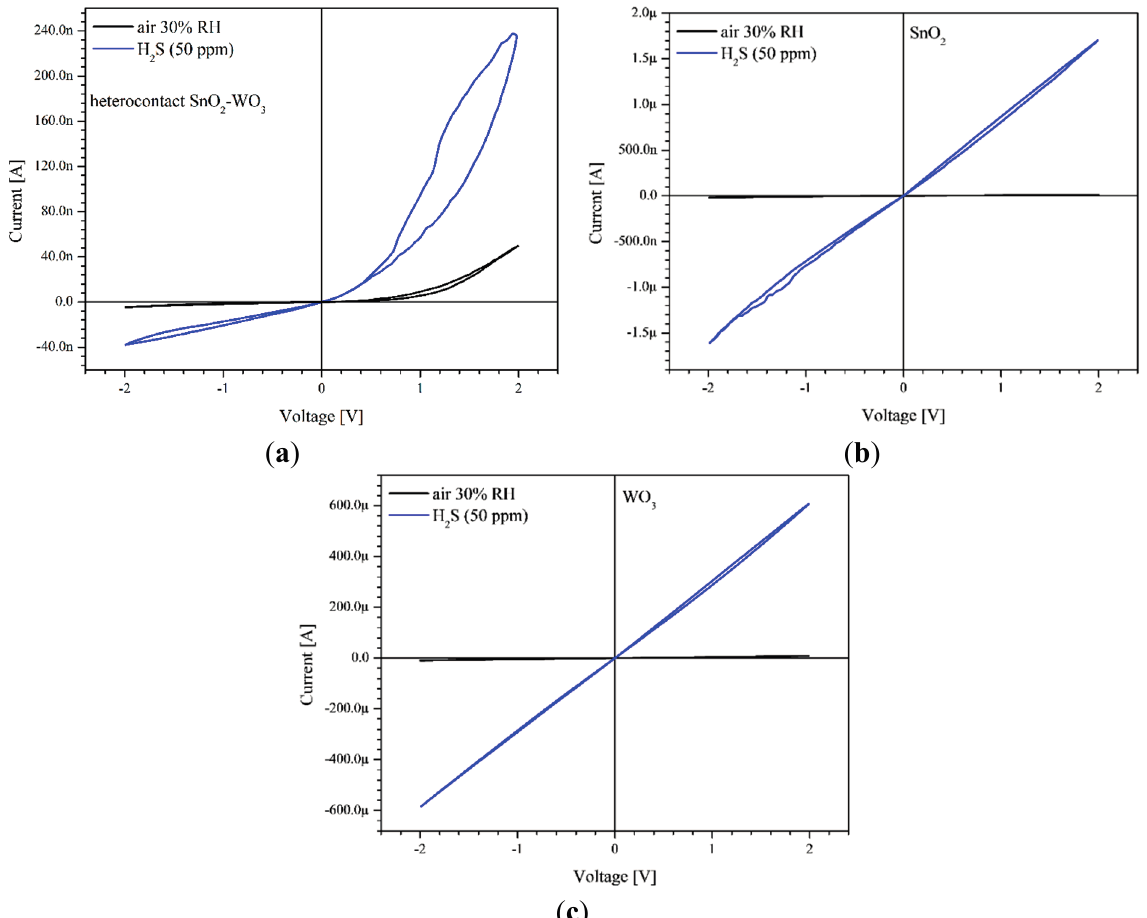
Figure 7. Current-voltage characteristics of sensors with: ( a ) SnO 2 |WO 3 heterocontact; ( b ) SnO 2 layer; ( c ) WO 3 layer in the air atmosphere and air that containing 50 ppm of hydrogen sulphide. Relative humidity of air 30%; measurement temperature 300